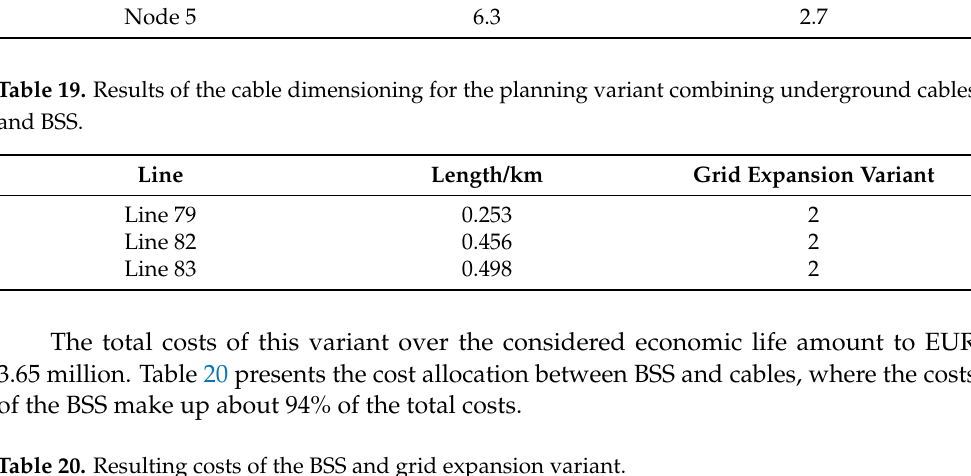
Table 20. Resulting costs of the BSS and grid expansion